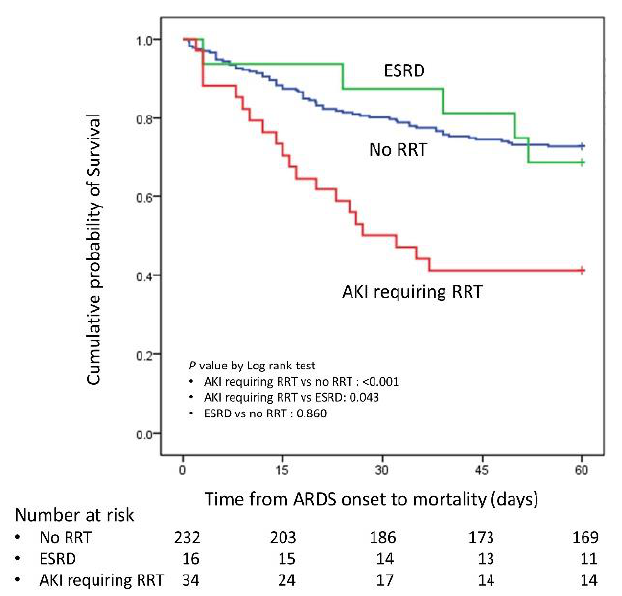
Figure 2. Kaplan – Meier curve for AKI requiring RRT, ESRD and no RRT; RRT: renal replacement Figure 2. Kaplan–Meier curve for AKI requiring RRT, ESRD and no RRT; RRT: renal replacement therapy; AKI: acute kidney injury; ESRD: end stage renal disease. therapy; AKI: acute kidney injury; ESRD: end stage renal